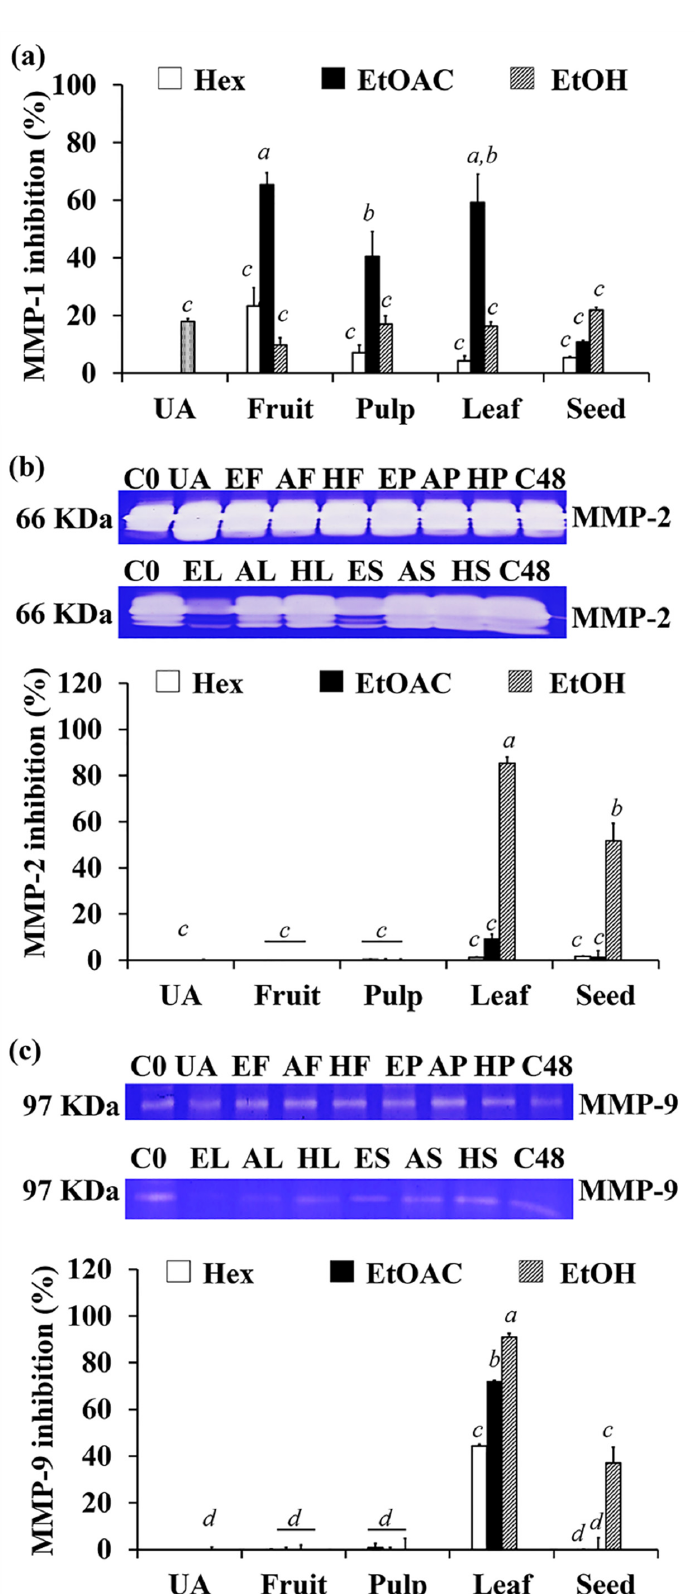
Figure 4. Inhibition against MMP-1 ( a ), MMP-2 ( b ), and MMP-9 ( c ) of 1 mg/mL ursolic acid (UA) and various parts of C. carandas sequentially extracted using n -hexane (Hex), ethyl acetate (EtOAc),